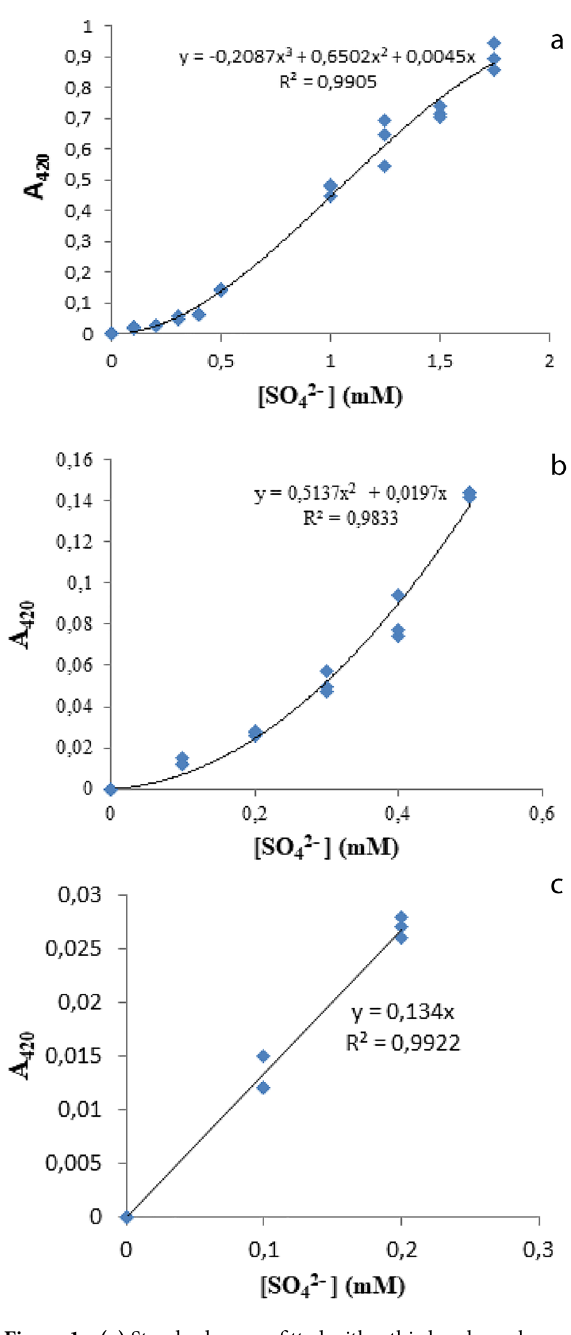
Figure 1. (a) Standard curves fitted with a third-order polynomial, (b) second order polynomial and (c) linear. These curves are described by their equations and their correlation values (R 2 ), where y is the absorbance at 420 nm (A 420 ) of a sample and x is the corresponding sulfate concentration [SO 42− ]in